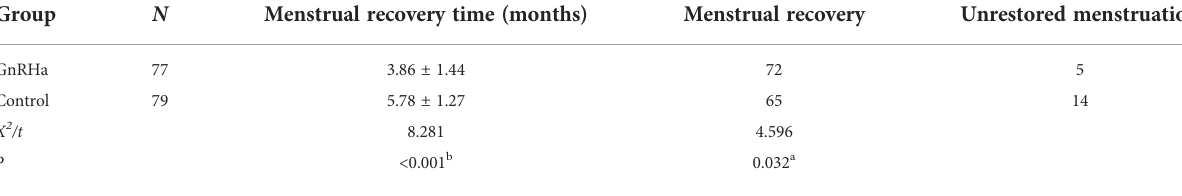
TABLE 4 Comparison of menstrual recovery after chemotherapy between the two groups. Group